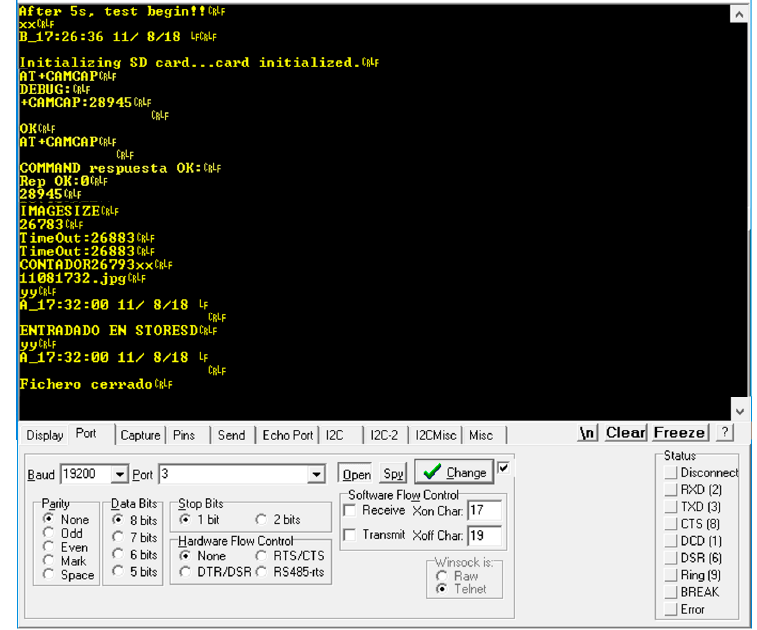
Figure 7. Sample view of the control and verification console, with check commands received.